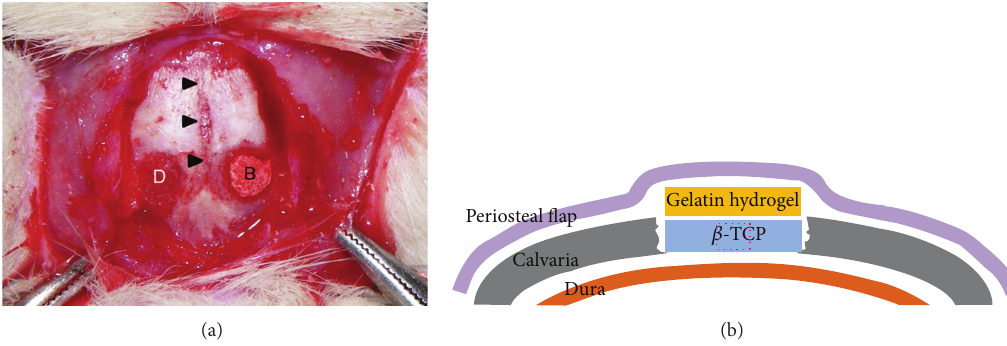
Figure 1: Surgical images. (a) Intraoperative view of rat calvaria. Two 5 mm diameter calvarial defects were created on each side of the sagittal suture (arrow heads). The defects were filled with a beta-tricalcium phosphate disc (B) or left untreated with exposed dura (D). (b) Schematic of a cross section of the calvarial defect. The dotted square in 𝛽 -TCP indicates the most-central area where histomorphometric analysis was